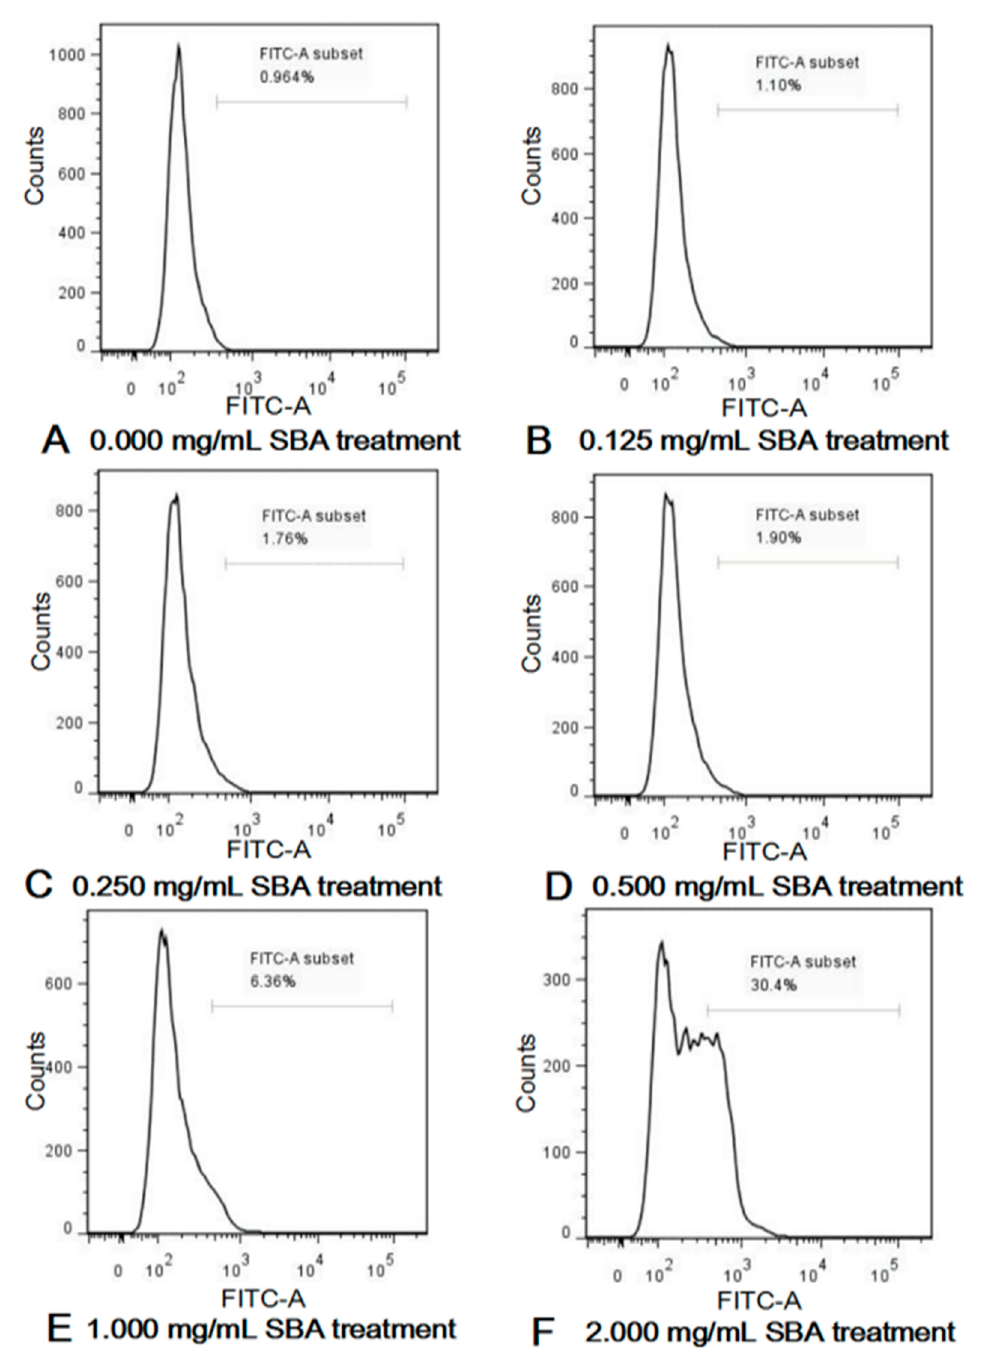
Figure 3. ( A–F ) SBA induced cell apoptosis in IPEC-J2. IPEC-J2 was cultured with 0, 0.125, 0.25, 0.5, 1.0 or 2.0 mg/mL SBA for 24 h. Cell apoptosis was determined by FCM and shown in Control, 0.000 mg/mL SBA treatment ( A ); 0.125 mg/mL SBA treatment ( B ); 0.250 mg/mL SBA treatment ( C ); 0.500 mg/mL SBA treatment ( D ); 1.000 mg/mL SBA treatment ( E ); 2.000 mg/mL SBA treatment ( F ).